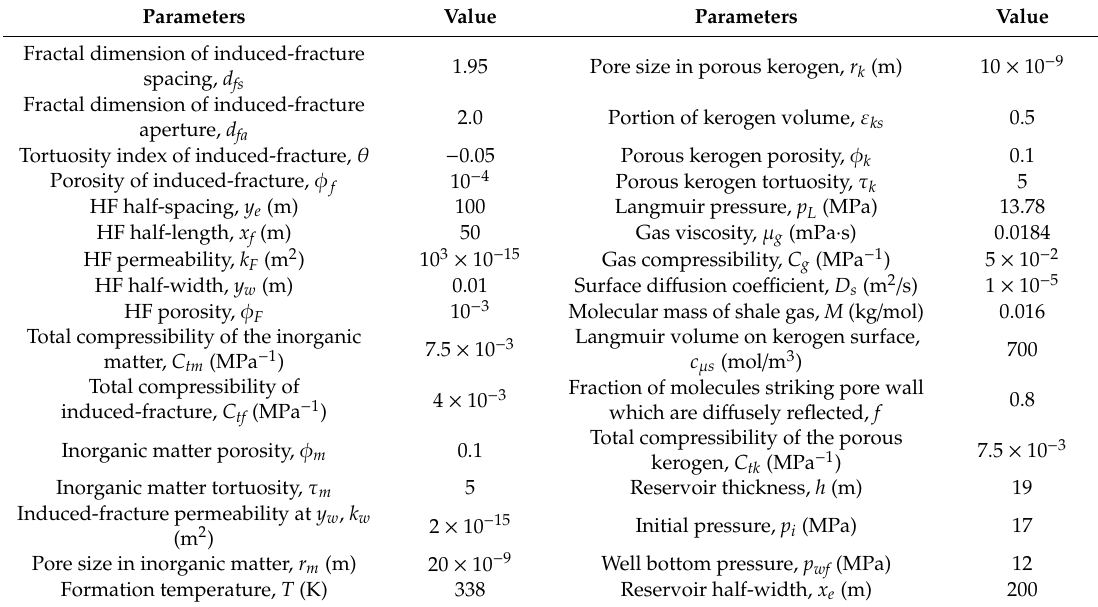
Table 1. Parameters used in multi-linear flow model (FMFM) and Sheng’s model [20]. Parameters Value Parameters Value Fractal dimension of induced-fracture spacing, d fs